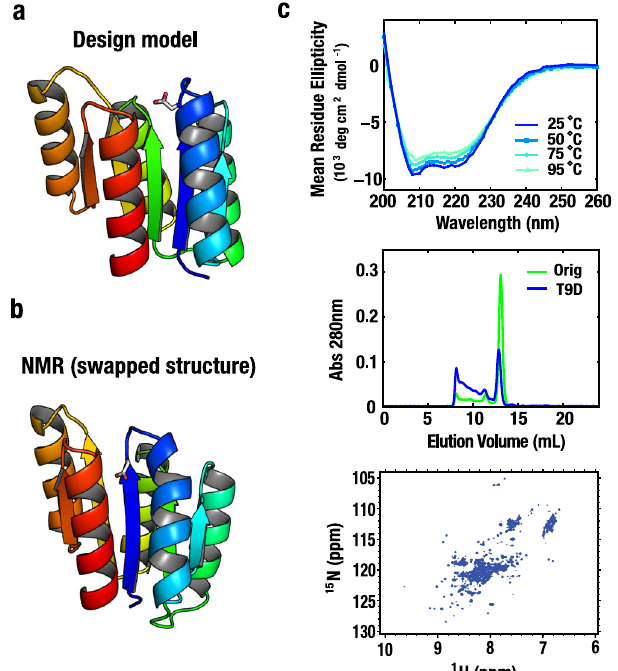
Fig. 4 Strand-swapped structure is robust to negative design. The mutation T9D in a the design model and b the NMR structure of R2×3_BP1_B9. Both mutated structures were generated by using Foldit 53 followed by Rosetta minimization 25 . c (top) Temperature dependence of the CD spectra of the T9D mutant. (middle) Size exclusion chromatograms at 280 nm of the original R2×3_BP1_B9 (Orig) and the T9D mutant. (bottom) Two-dimensional 1 H- 15 N HSQC spectrum of the T9D mutant at 25 °C and 600